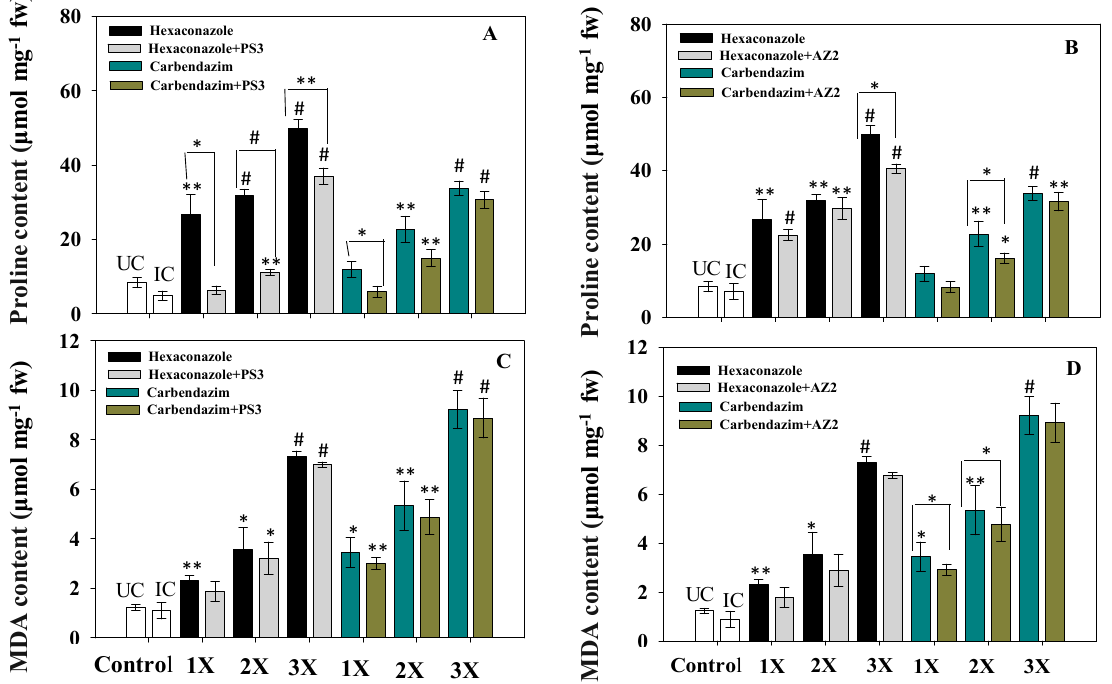
Figure 9. Bio-inoculation impact of Pseudomonas sp. PS3 ( A ) and Pseudomonas sp. AZ2 ( B ) on proline content accumulated in fresh foliage (fw) of R. sativus grown in soil treated with varying concentrations of carbendazim and hexaconazole. Inoculation impact of Pseudomonas sp. PS3 ( C ) and Pseudomonas sp. AZ2 ( D ) on malondialdehyde (MDA) content of radish foliage raised in soils treated with di ff erent concentrations of carbendazim and hexaconazole. Histograms represent the mean value of three independent replicates ( n = 3), and error bars represent S.D. The asterisks *, ** and # denote statistical significance at p < 0.05, p < 0.005 and p < 0.001, respectively computed by Student’s t -test. UC = Uninoculated control, IC = Inoculated control. 1X, 2X and 3X denote the normal, two times and three times greater concentrations of fungicide.